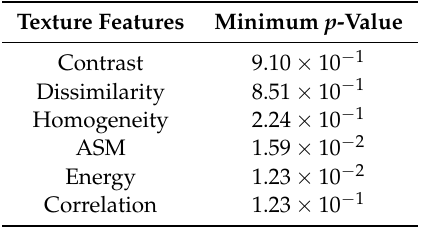
Table 2. Minimum value of texture feature chi - square